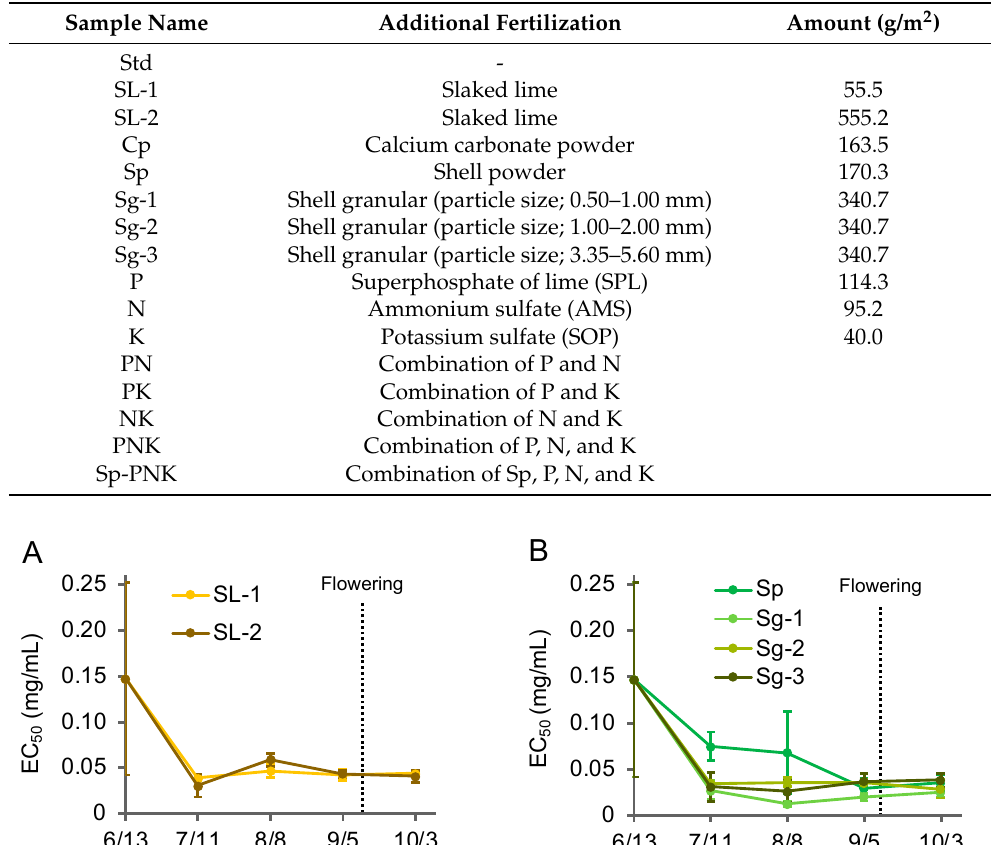
Table 1. Multiple Fertilization Conditions in 2019.